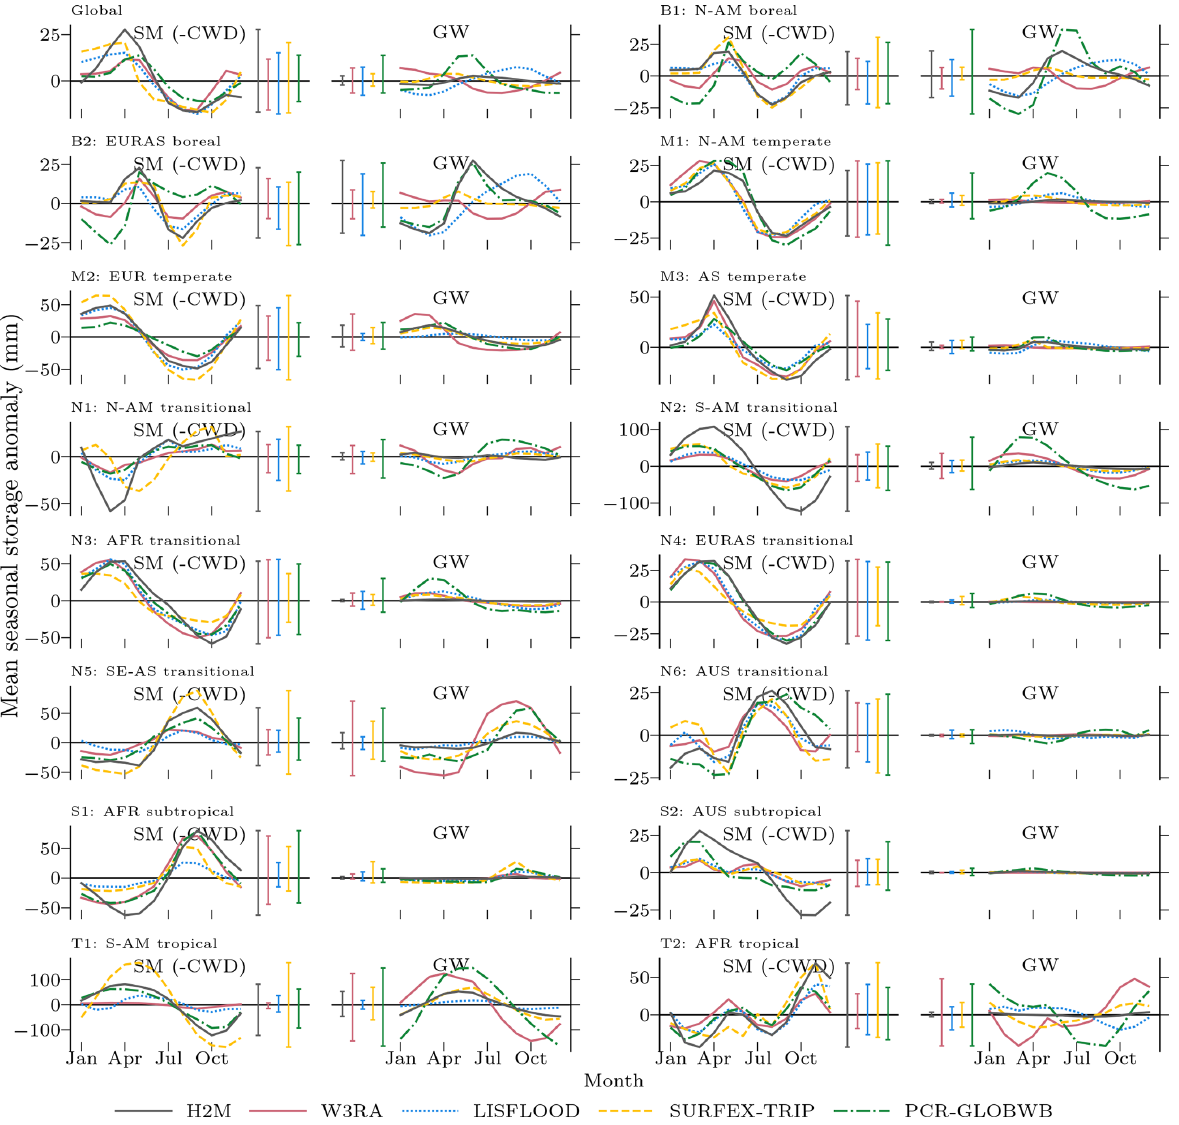
Figure B3. Global and regional mean seasonal anomalies of soil moisture (SM) and groundwater (GW) for the hybrid model (H2M) and the process-based global hydrological models. Note that SM corresponds to negative modeled cumulative water deficit (CWD). Ranges from the minimum to the maximum value per model are shown next to the seasonal cycle as vertical lines. The regions are shown in Fig. 2. Surface storage is included in the groundwater component for the models SURFEX-TRIP and PCR-GLOBWB. The plots are based on global daily cell time steps from 2009 to 2014. Note that the y scale is consistent within, but differs across,